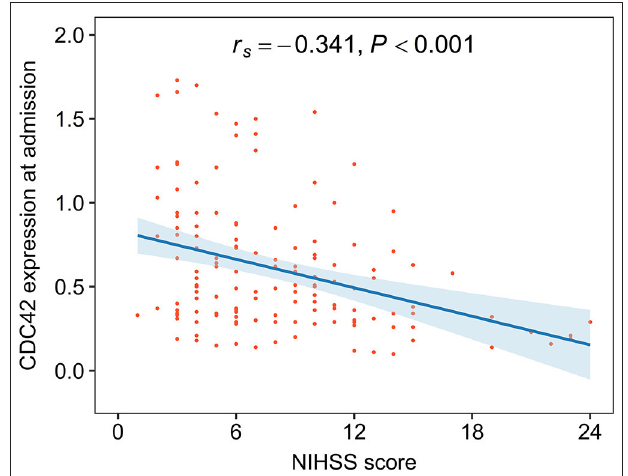
7 days ( n = 128) after admission; 1 month ( n = 121), 3 months ( n = 114), 6 months ( n = 109), 1 year ( n = 100), 2 years ( n =